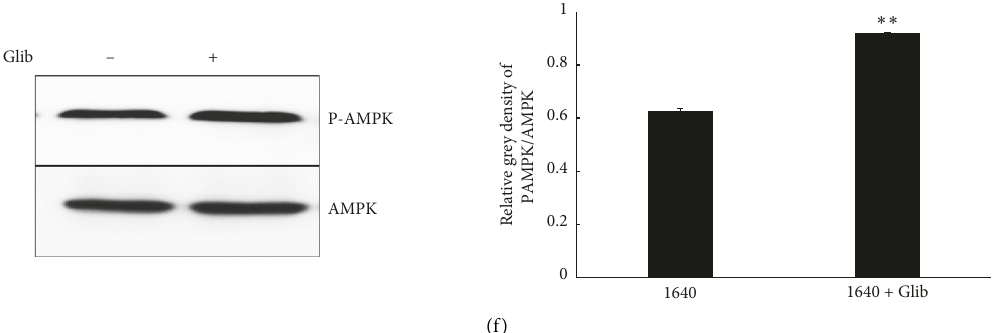
Figure 2: Glibenclamide induced autophagy in MIN-6 cells through the AMPK pathway. (a) Cell immunofluorescence analysis. MIN-6 cells were cultured with or without 10 μ M glibenclamide in 1640 medium and stained with an anti-LC3 antibody and then observed using a laser confocal microscope. Scale bar: 5 μ m. (b) Statistical results of the cell immunofluorescence test. shown are mean SEM of values from at least 30 cells with triplicate samples. (c–f) Western blot analysis and statistical results of protein quantification. MIN-6 cells were immunoblotted with different antibodies against (c) LC3 and GAPDH; (d) P-S6K and S6K; (e) P-mTOR and m-TOR; and (f) P-AMPK and ±